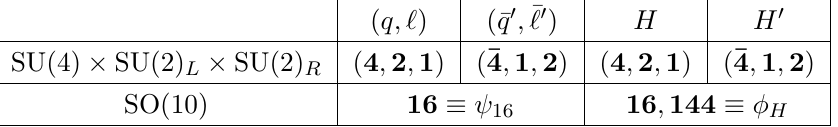
Table 6 . SO(10) embedding of quarks, leptons and